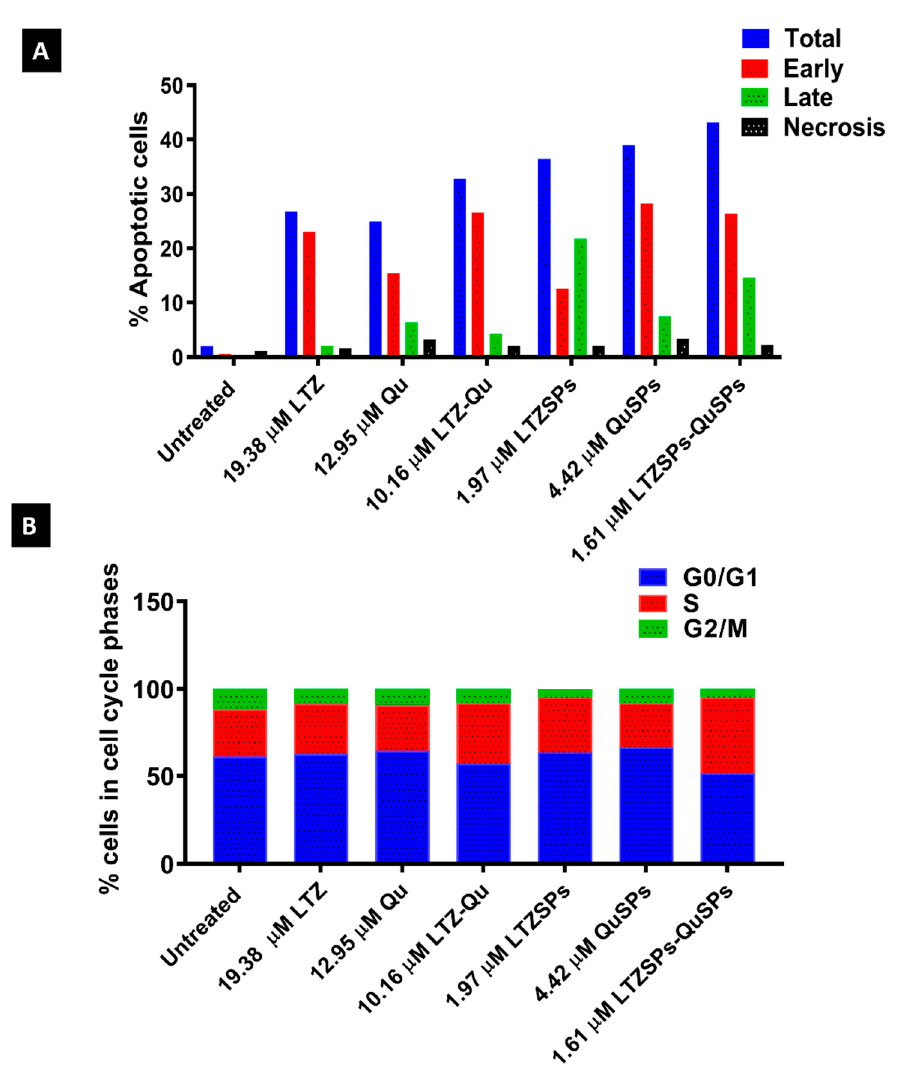
Figure 6. Cell cycle studies of MCF-7 cells treated with soluble LTZ, Qu, and their combination and also LTZSPs, QuSPs, and their combination using indicated concentrations. ( A ) Percentage of apoptotic cells. ( B ) Representative histograms indicating percentage of MCF-7 cells in each cell cycle. Abbreviations: LTZ; letrozole, Qu; quercetin, LTZSPs; letrozole-loaded spanlastics, QuSPs; quercetin-loaded spanlastics.